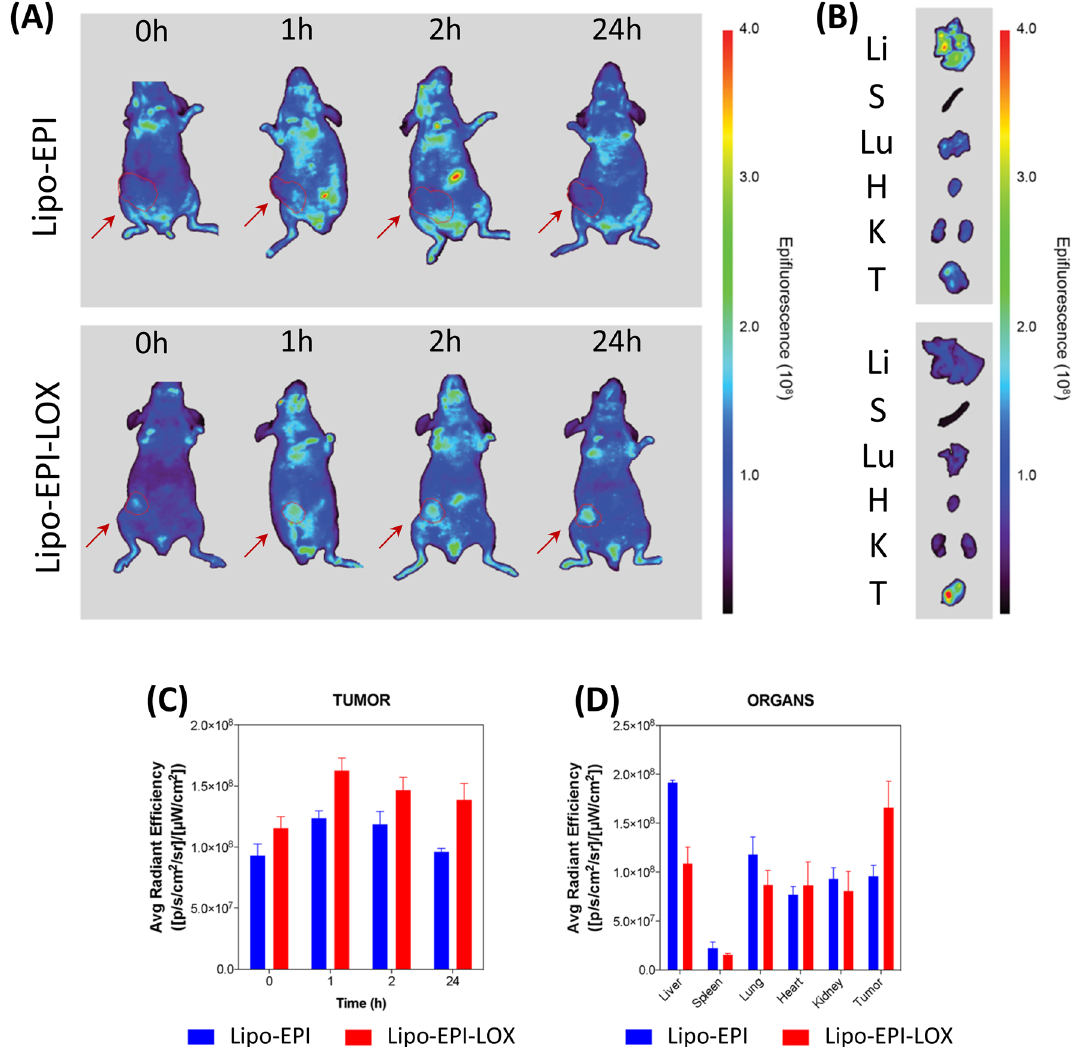
Figure 3. ( A ) In vivo biodistribution analysis of Lipo-EPI and Lipo-EPI-LOX in orthotropic xenograft mouse model of human TNBC at different time points (0, 1, 2 and 24 h post injections). ( B ) bioluminescence and fluorescence analysis of explanted organs (liver, spleen, lungs, heart, kidneys, tumors) to detect EPI localization. ( C ) Lipo-EPI and Lipo-EPI-LOX fluorescent signal quantification in tumor. ( D ) Lipo-EPI and Lipo-EPI-LOX fluorescent signal quantification in explanted